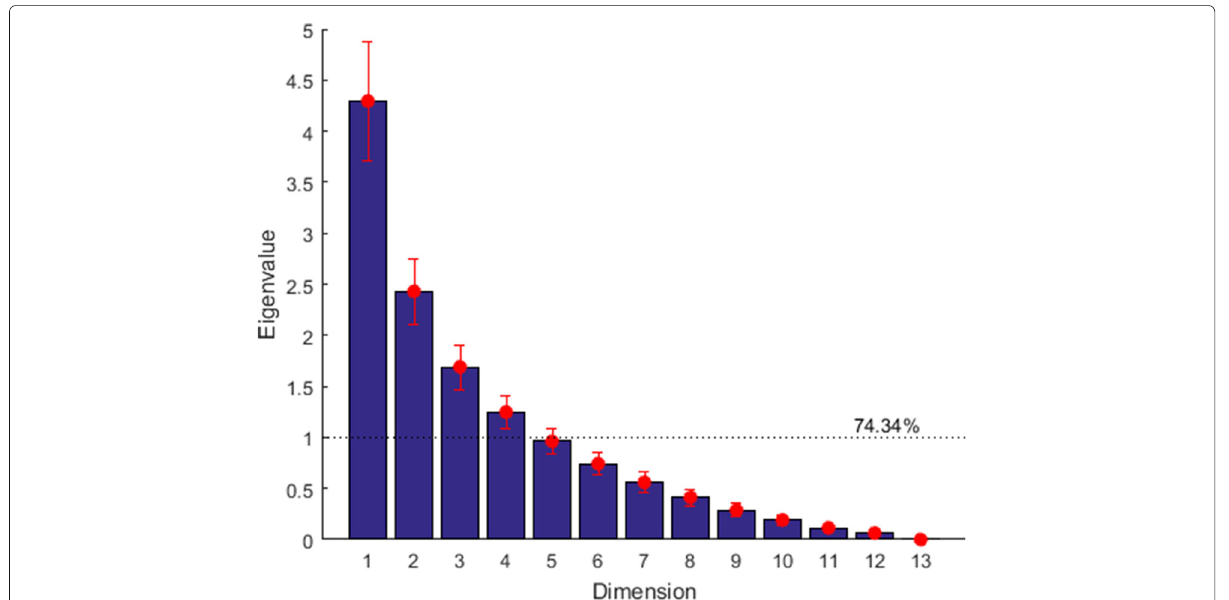
Fig. 2 Scree plot showing eigenvalues of the decomposition of the full 13-characteristic dataset. The dottedline shows the Kaiser-Guttman reference line for eigenvalues>1 indicating that at least four of the 13 dimensions are relevant. These account for 74.34% of the total variance in the 13-dimensional dataset. Error bars show standard errors for 1000 bootstrap replicates of the CA analysis